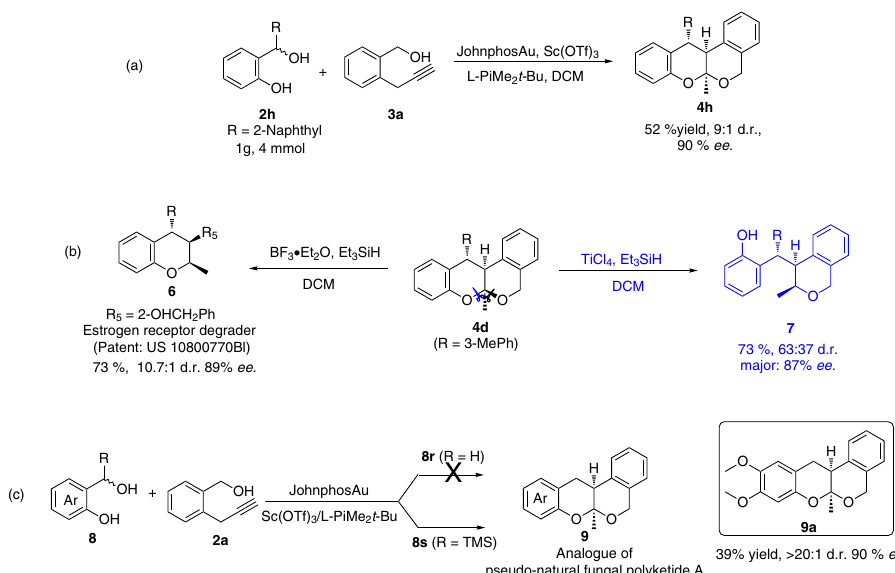
Fig. 5 The gram scale experiment and transformations of product 4. a The gram scale experiment. b Reduction of product 4d . c Synthesis of analogue of pseudo-natural fungal polyketide A .